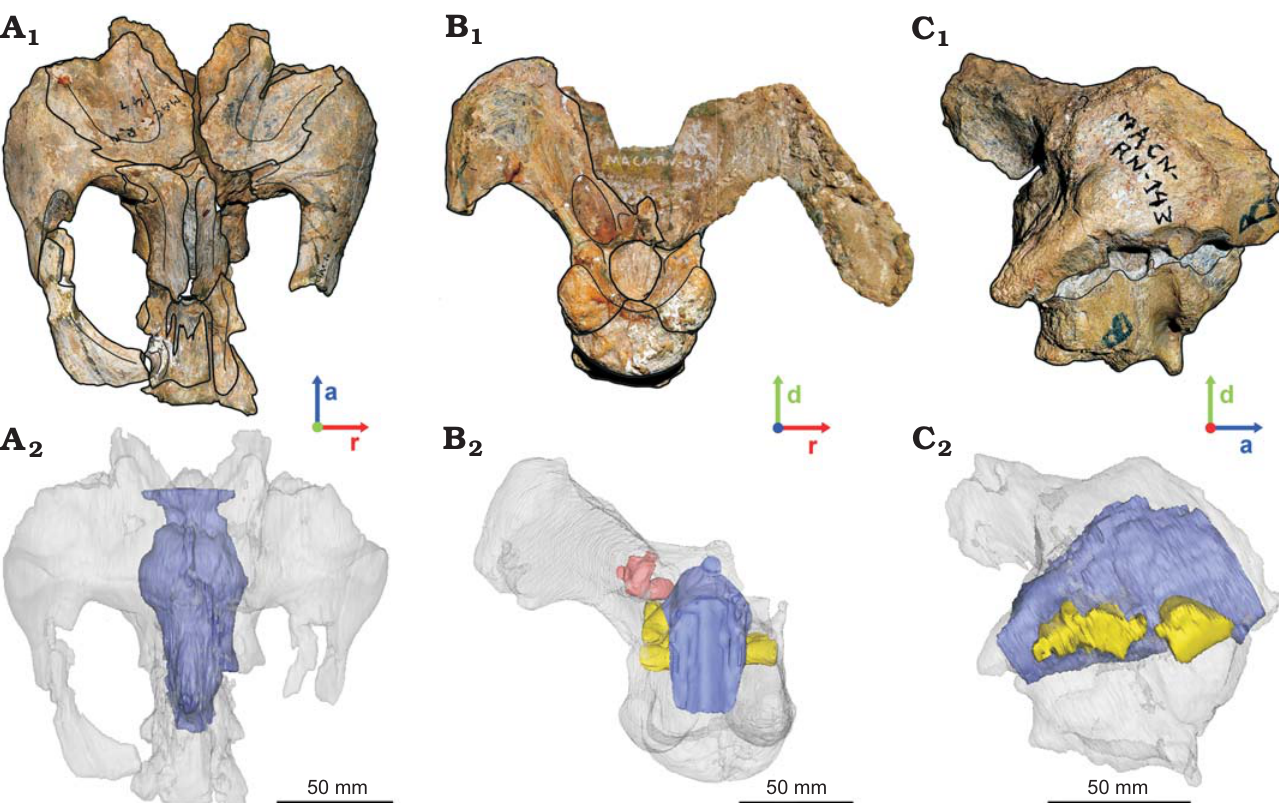
Fig. 1. Hadrosaurid dinosaur Secernosaurus koerneri Brett-Surman, 1979 from the late Campanian–early Maastrichtian, Los Alamitos Formation of North Patagonia, braincases and their reconstructed endocasts. A . MACN-RN 144 in dorsal view. B . MACN-RN 02 in posterior view. C . MACN-RN 143 in lateral view. Photographs (A 1 –C 1 ), CT-scan rendition of endocasts (A 2 –C 2 ). Transparent gray, braincase; blue, encephalon; pink, inner ear; yellow, foramina of the cranial nerves. Abbreviations: a, anterior; d, dorsal; r, right.